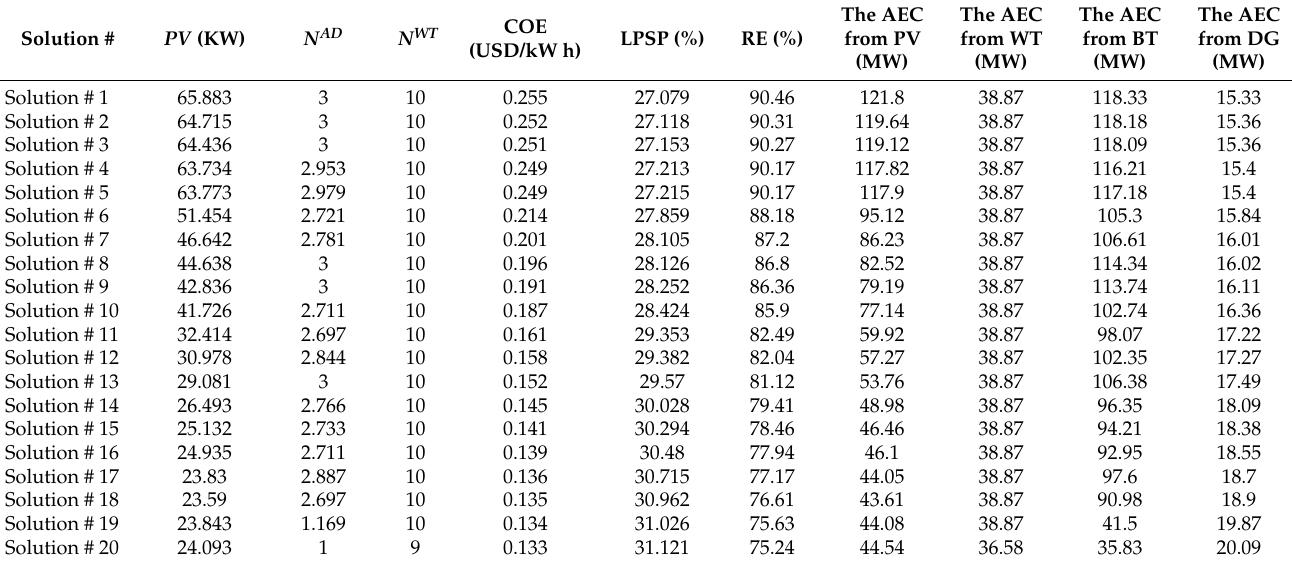
Table 6. Selected solutions from the Pareto front of